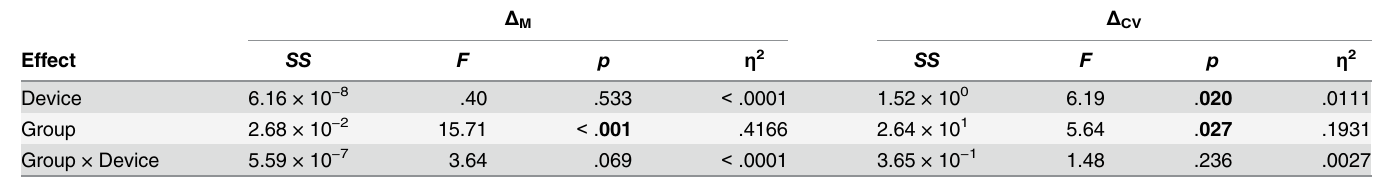
Table 5. Statistics associated with the Group × Device ANOVA for step time outcome measures during self-paced walking.